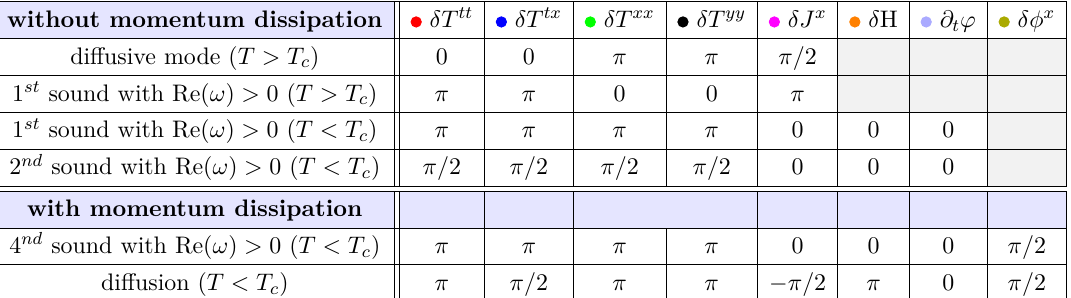
Table 1 . The phase differences modulo 2 π with respect to δJ t for the various fluctuations for the normal fluid ( T > T ) and superfluid ( T < T ) phases for temperatures sufficiently far from the c c phase transition and in the ideal limit k → 0 . The gray cells indicate that such a fluctuation is not present in the corresponding mode. In the case of the sound modes, the phases of the “partner” mode may be obtained by taking into account that the phases add up to 0 (for parity even operators) and π (for parity odd operators), respectively. Concretely, the computation of the phases for the momentum dissipation case has been performed for α/T = 6